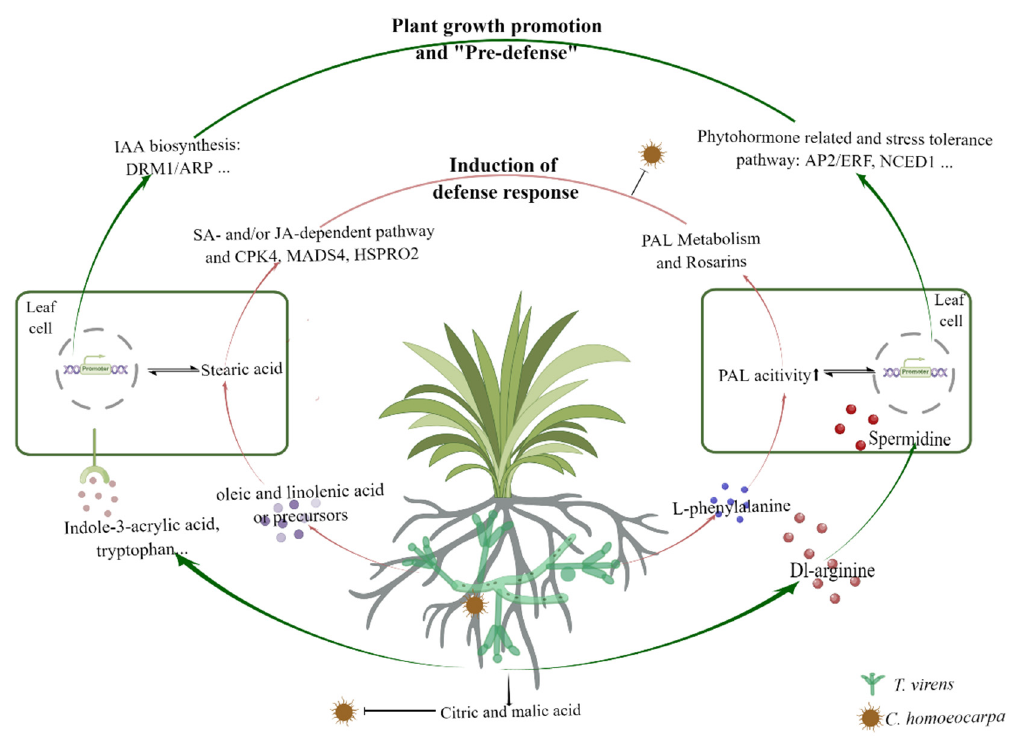
Figure 6. Overview of dual mechanism induced by T. virens under the C. homoeocarpa attack.